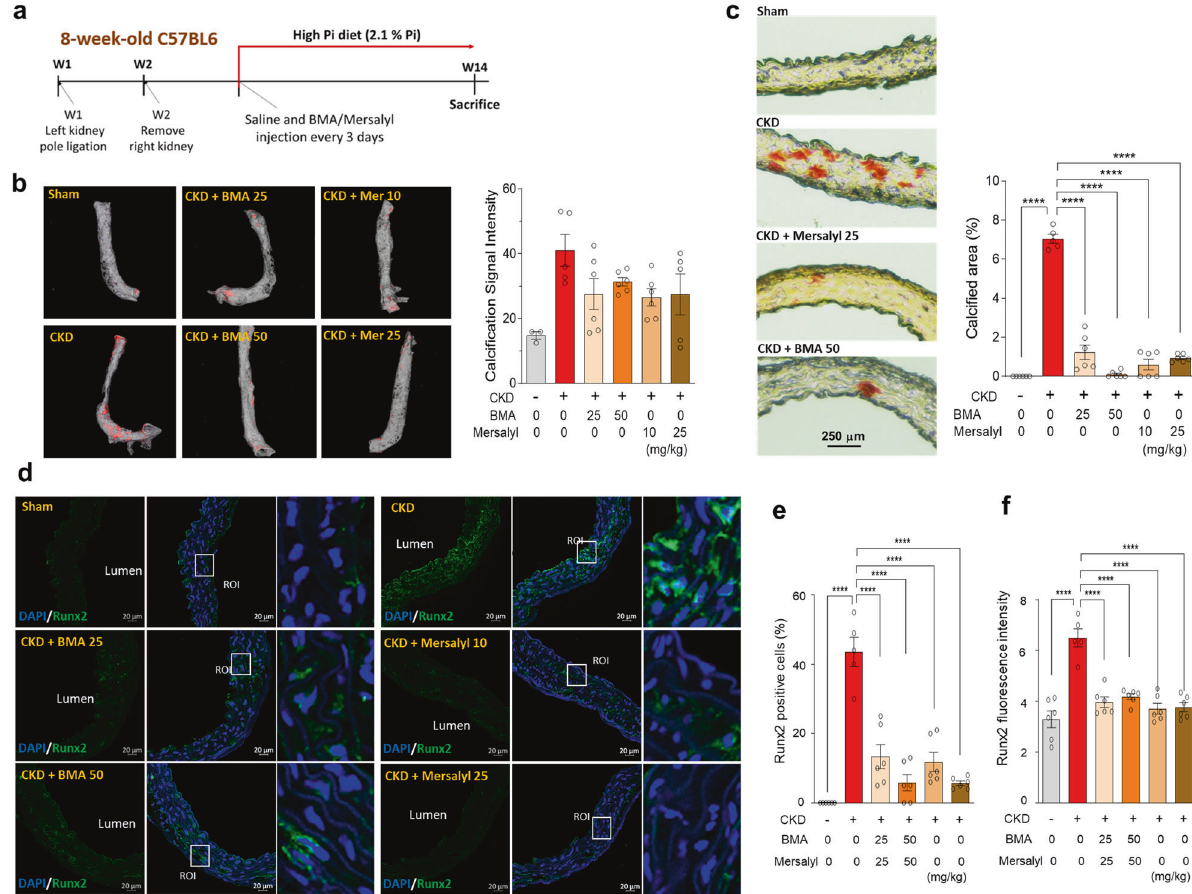
Fig. 4 Inhibiting mitochondrial phosphate (Pi) transport attenuates vascular calci fi cation in mice with chronic kidney disease. a Timeline of surgery and drug treatments in 5/6 nephrectomy mice. b Calci fi ed areas in the aortic rings of 5/6 nephrectomy mice were visualized by micro-CT imaging (# mice; n = 3 – 6). c Alizarin Red S staining was used to identify the microcalci fi ed areas (# mice; n = 5 – 6). d Immunostaining of Runx2 in microsections of mouse aortic rings, Runx2 = green, nuclei = blue. e , f Bar graph showing the number of RunX2-positive cells and the Runx2 fl uorescence intensity after normalization (# mice; n = 5 – 6). The data were analyzed using one-way ANOVA. **** P <